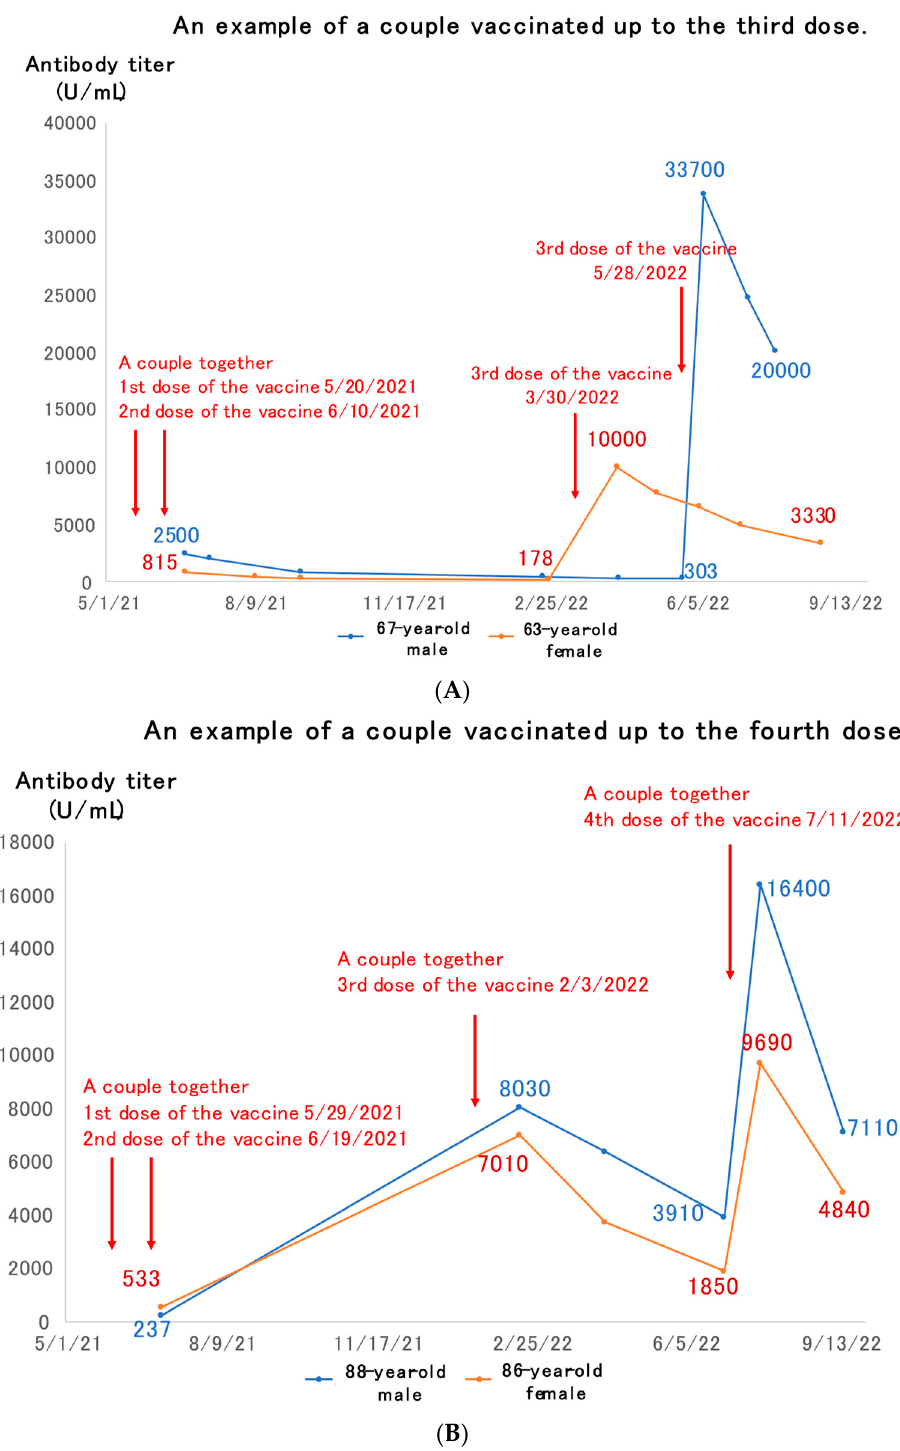
Figure 2. Examples of couples vaccinated up to the third ( A ) or fourth ( B ) dose of vaccine.